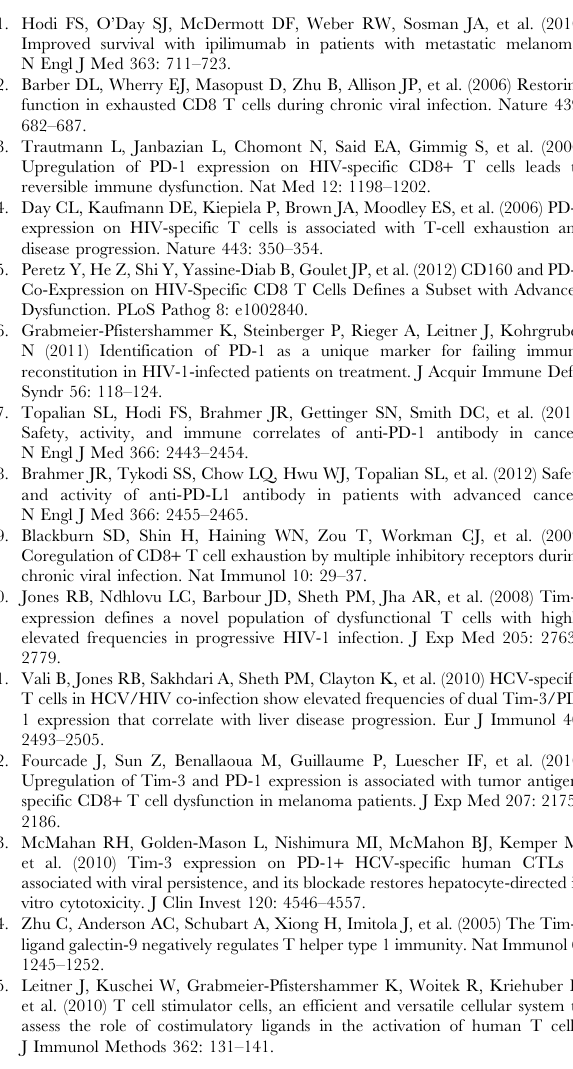
Figure S3 Parental Bw cells (Bw control) and Bw cells transduced to express PD-1 or TIM-3 were stained with PE- labelled isotype control antibody (IgG-PE) or PD-1-PE and TIM- 3-PE as indicated and analyzed by flow cytometry. Figure S4 A) Percentage of TIM-3 positive cells in the CD45RA + CD8 T cell subset from suppressed (S) and viremic (V) patients and from healthy individuals (H) are shown. Bars indicate median percentage. B) Co-expression of TIM-3 and PD-1 on total CD8 (upper right), CD8/CD45RA + (middle right) and CD8/CD45RA 2 T cells from a viremic patient. Figure S5 Comprehensive retroviral cDNA expression libraries generated from immature and mature dendritic cells (DC) and freshly isolated and in vitro activated human PBMC were co- expressed in Bw cells. Cells were probed with immunoglobulin (Ig) fusion proteins representing the extra-cellular domains of human CTLA-4 (‘‘Abatacept’’), human PD-1 or human TIM-3. Horse serum was used to block Fc-receptor binding. Bound immuno- globulin fusion proteins were detected with PE-conjugated goat- anti human IgG (Fc-specific) antibodies. The number